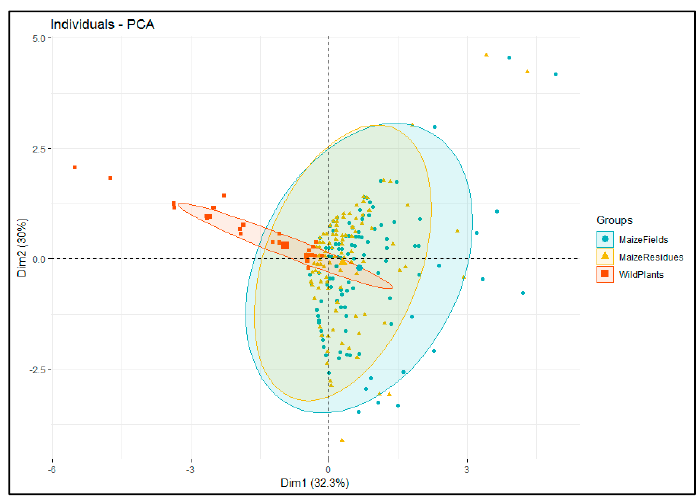
Figure 2. The principal component biplot showing the relation between abundance of stemborer species in maize plants of cultivated fields during cropping season and those in either maize residues or wild plants during non-cropping season.